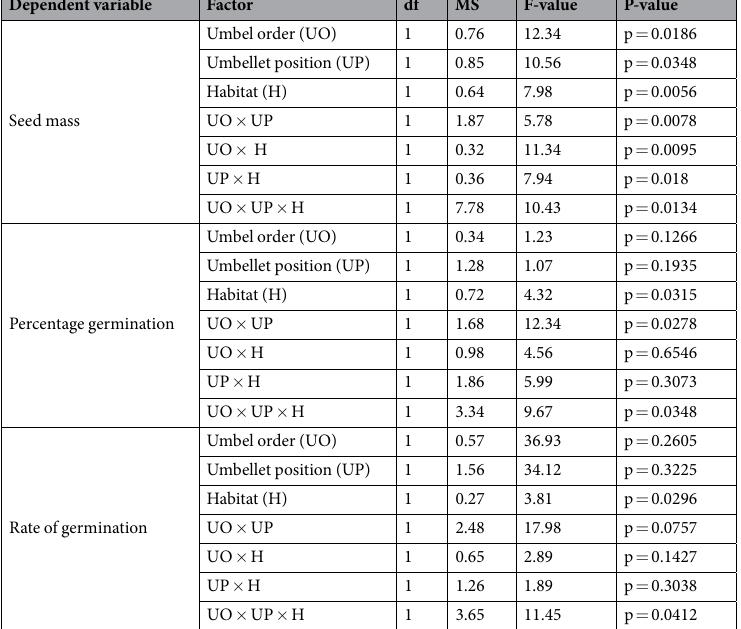
Table 5. Tree-way ANOVA of effect of umbel order (primary vs secondary), umbellet position (central vs outer) in the umbel, habitat (roadside vs forest), and their interaction on seed mass, percentage of germination and rate of germination of Peucedanum oreoselinum .